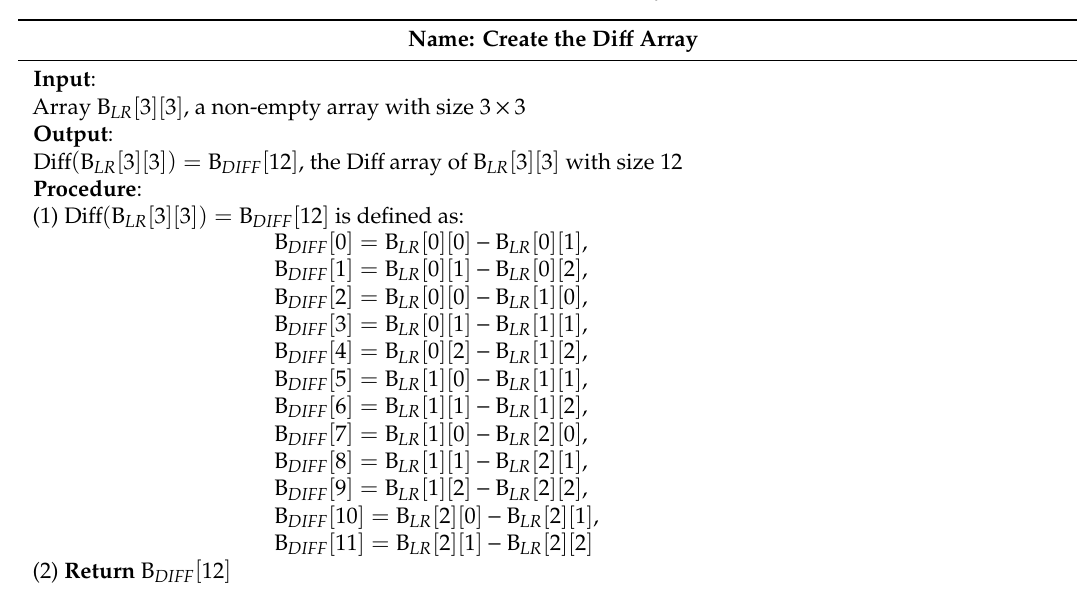
Table 1. The Di ff